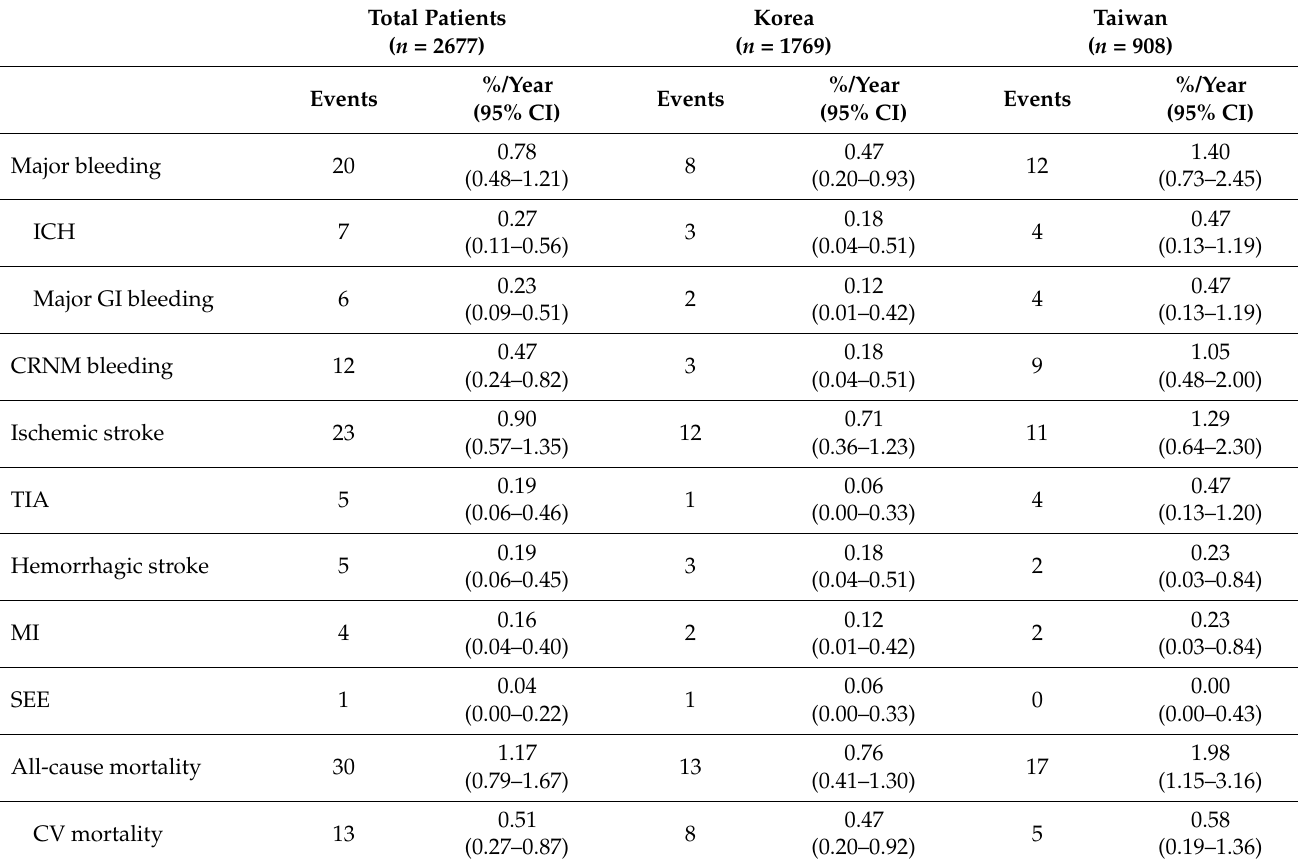
Table 2. One-year clinical events.